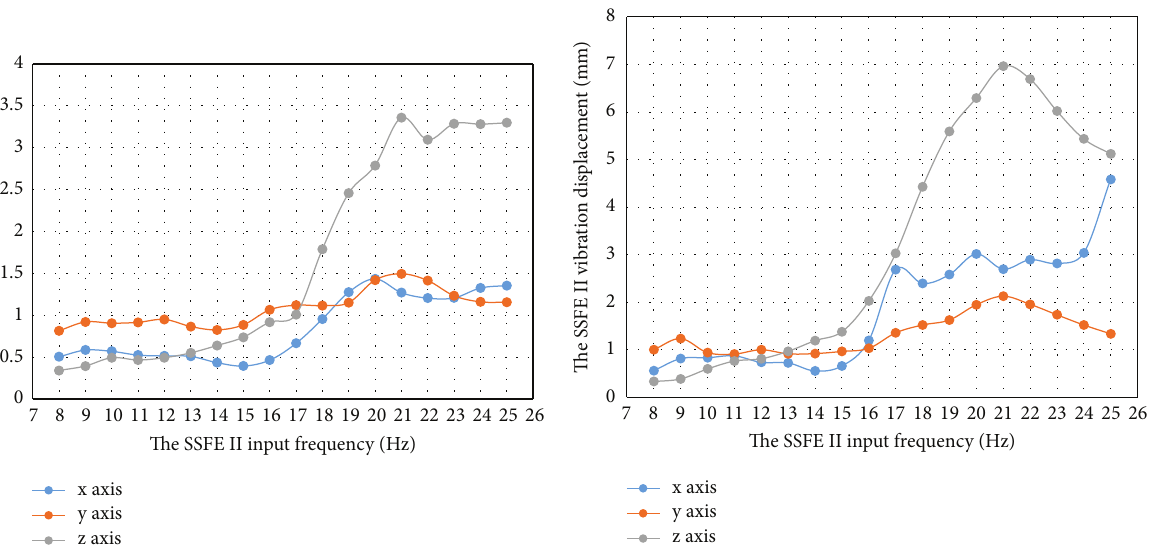
Figure 16: Along every direction, curves of the SSFE vibration displacements changing with the SSFE input frequency under different eccentric masses. (a) Along the x axis. (b) Along the y axis. (c) Along the z axis.